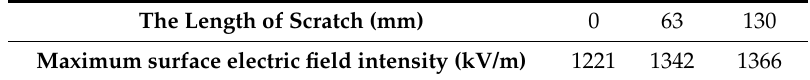
Table 5. Maximum surface electric field distribution with different length of scratches on Φ 1.3